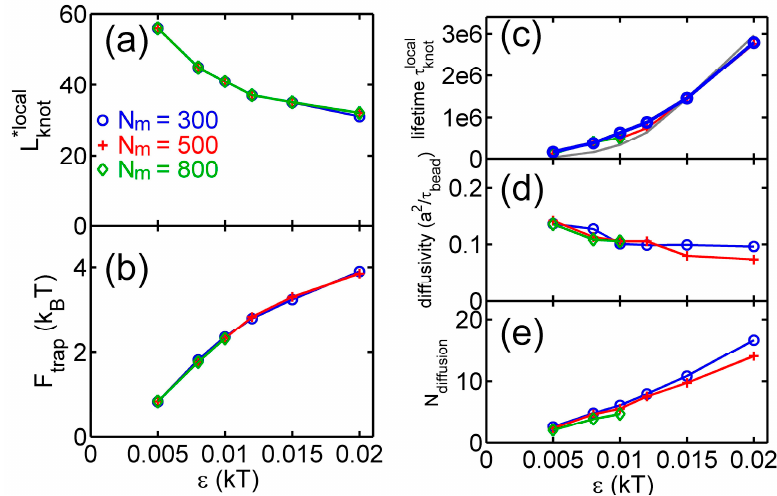
Figure 4. Results from simulations with parameter sets {a circular chain, N m = 300, 500 or 800, a triangle potential, R int = 10 σ }. ( a ) Metastable size of local knots. ( b ) The depth of potential well around local knots. ( c ) The lifetime τ local of local knots in units of τ bead . The gray curve is calculated from Equation (7). The data for N m = 800 is incomplete at large (cid:101) due to an insufficient number of hopping events in simulations. ( d ) The diffusivity D diffuse of a knot along the chain. The calculation of diffusivity is based on all data, including both tight and loose knots. ( e ) The normalized diffusion distance along the chain during the lifetime calculated from Equation (9).